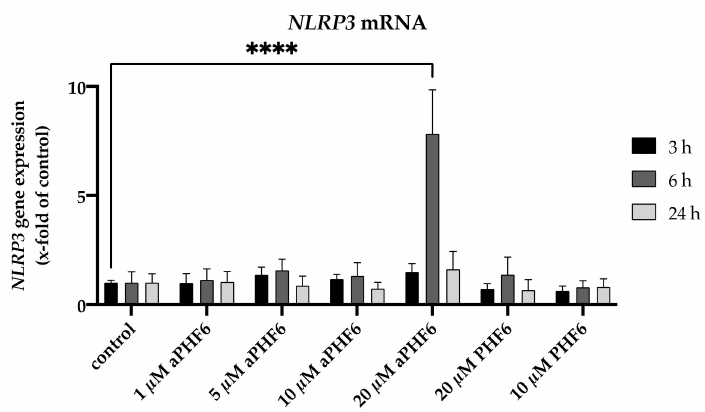
Figure A3. Effect of different concentrations of PHF6 on NLRP3 mRNA across three different time points (3, 6, and 24 h). aPHF6: aggregated PHF6; PHF6: unaggregated PHF6. **** p < 0.0001.